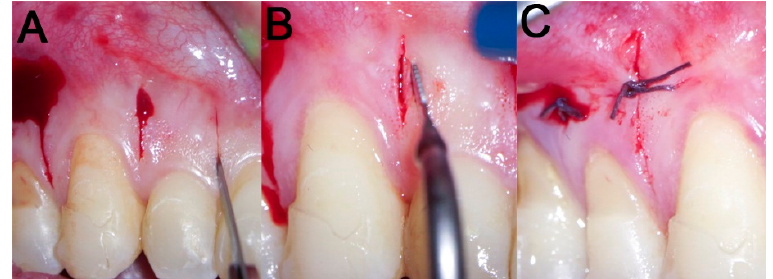
Figure 3. Surgical procedure: ( A ) incision with a 15 blade; ( B ) cortical incision with sonic device and